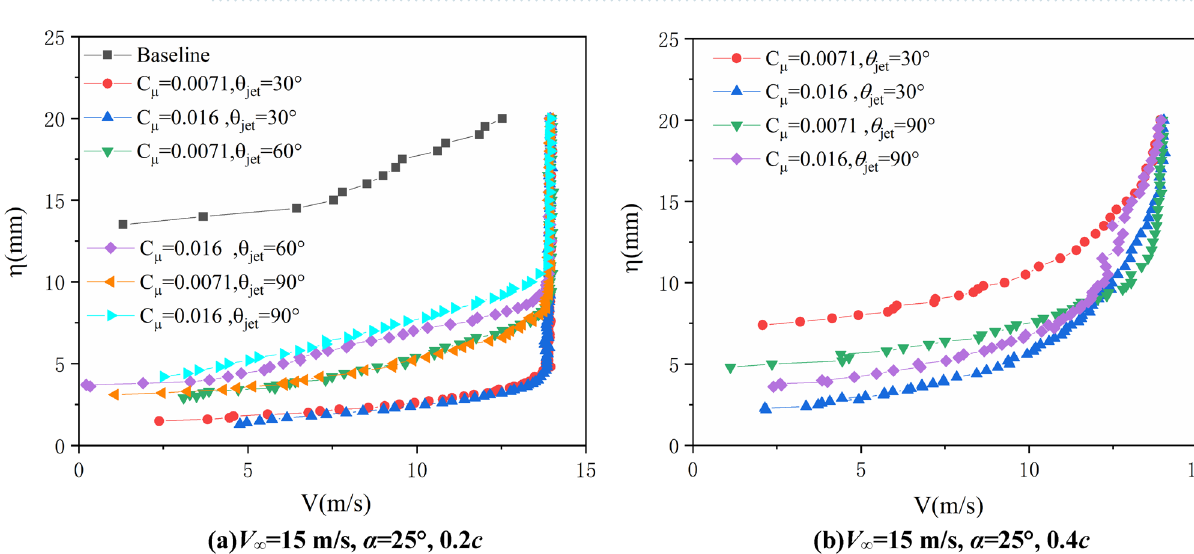
Figure 9. Test results of the boundary layer velocity profiles ( V ∞ = 15 m/s, α =